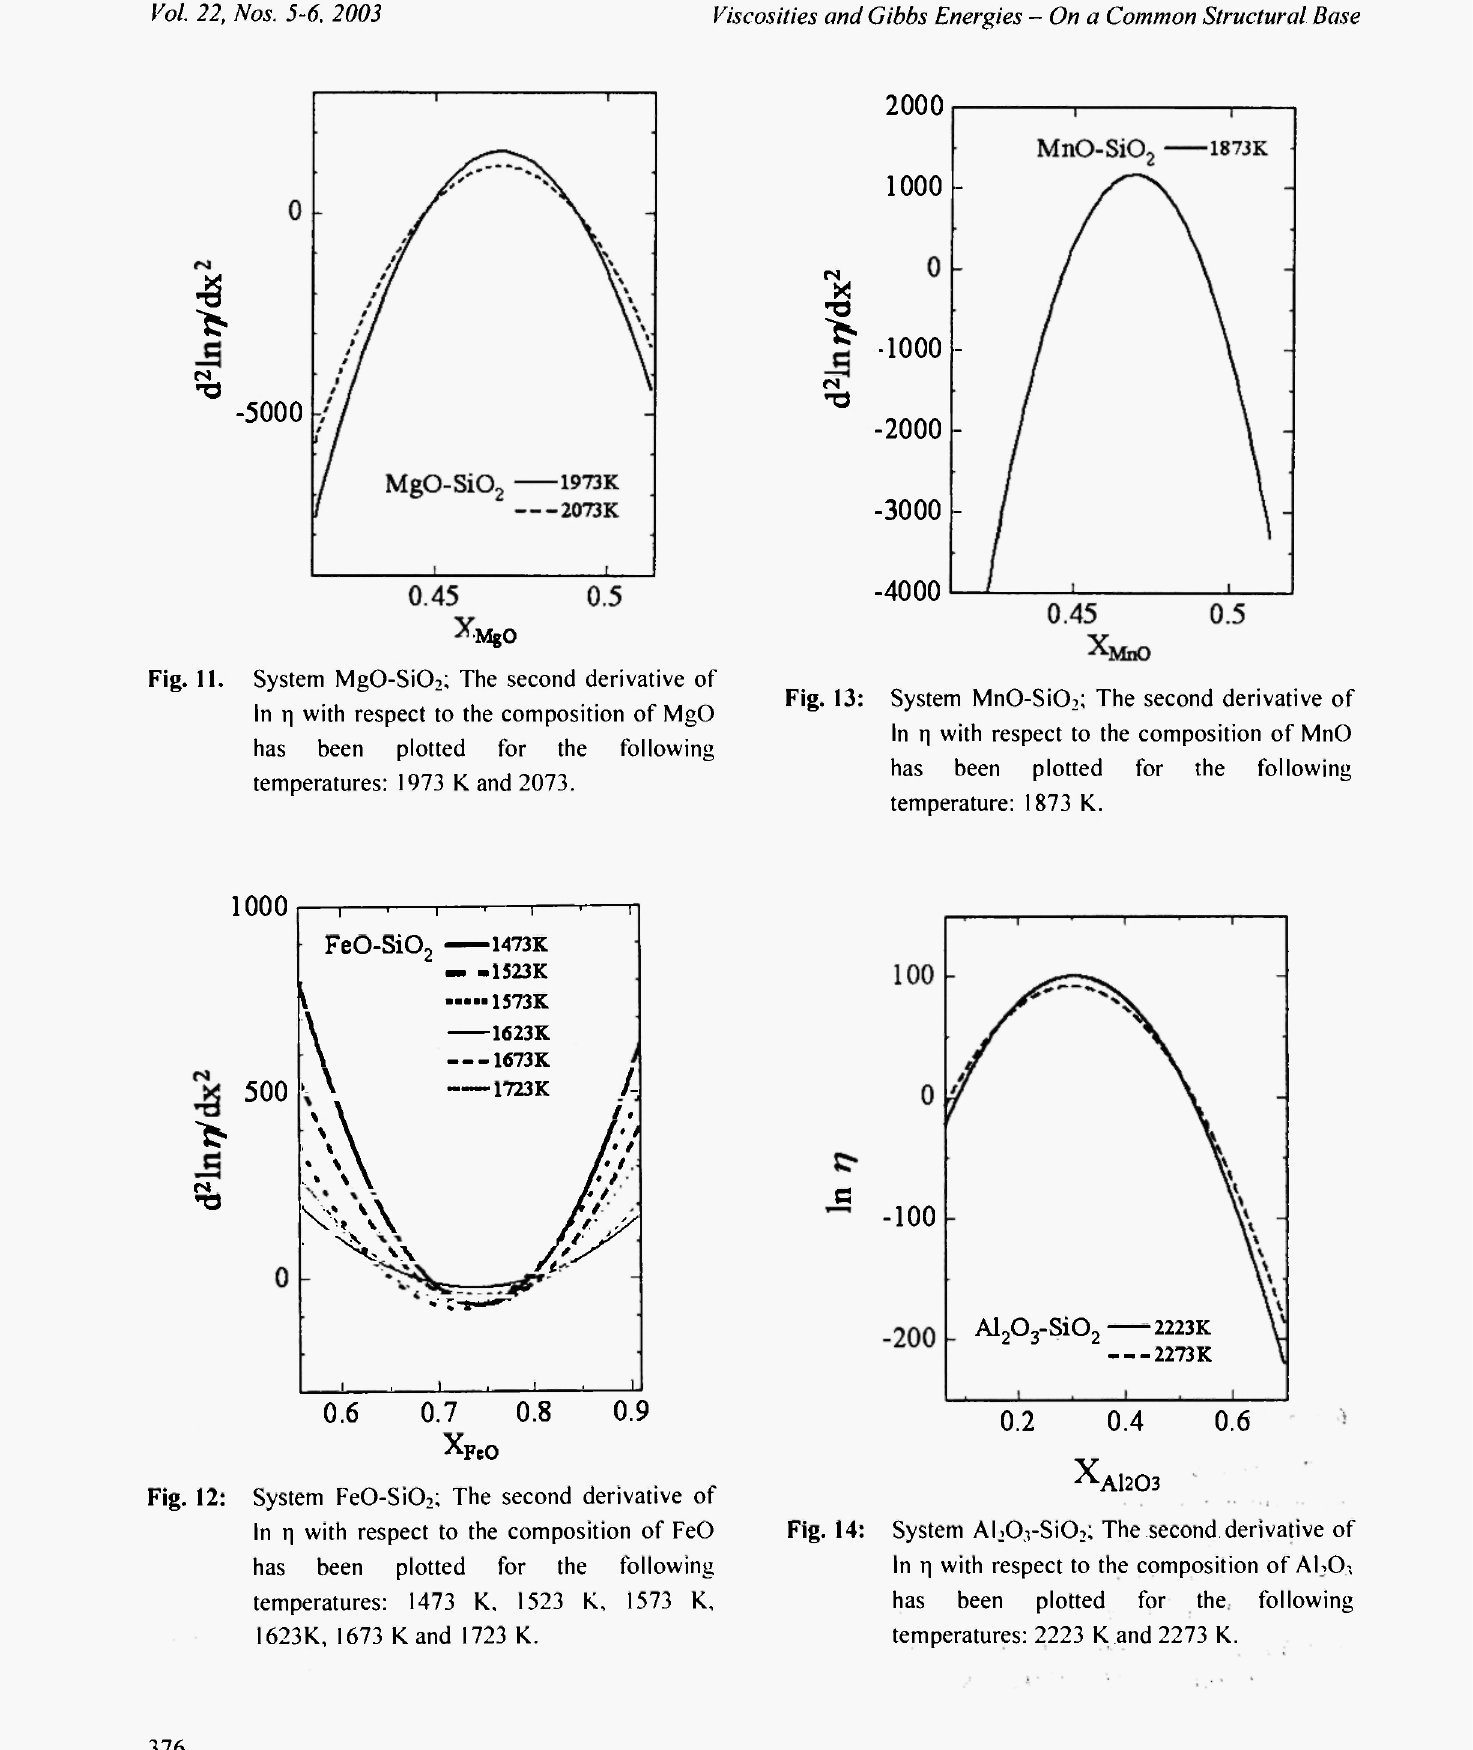
Fig. 14: System Alj0 r Si0 3 ; The second derivative of In η with respect to the composition of AKCh has been plotted for the temperatures: 2223 Κ and 2273